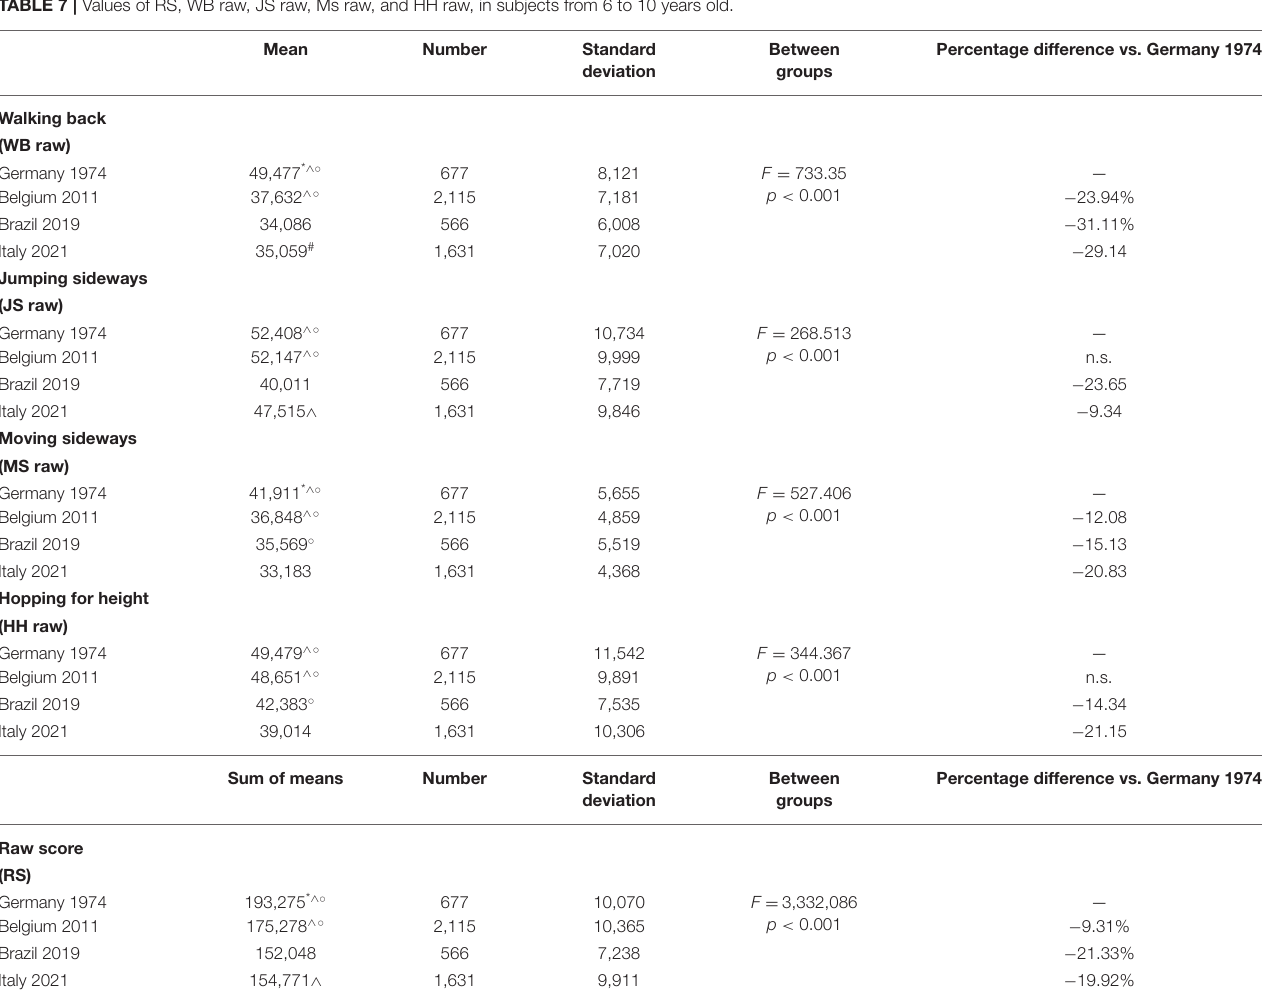
TABLE 7 | Values of RS, WB raw, JS raw, Ms raw, and HH raw, in subjects from 6 to 10 years old. Mean Standard